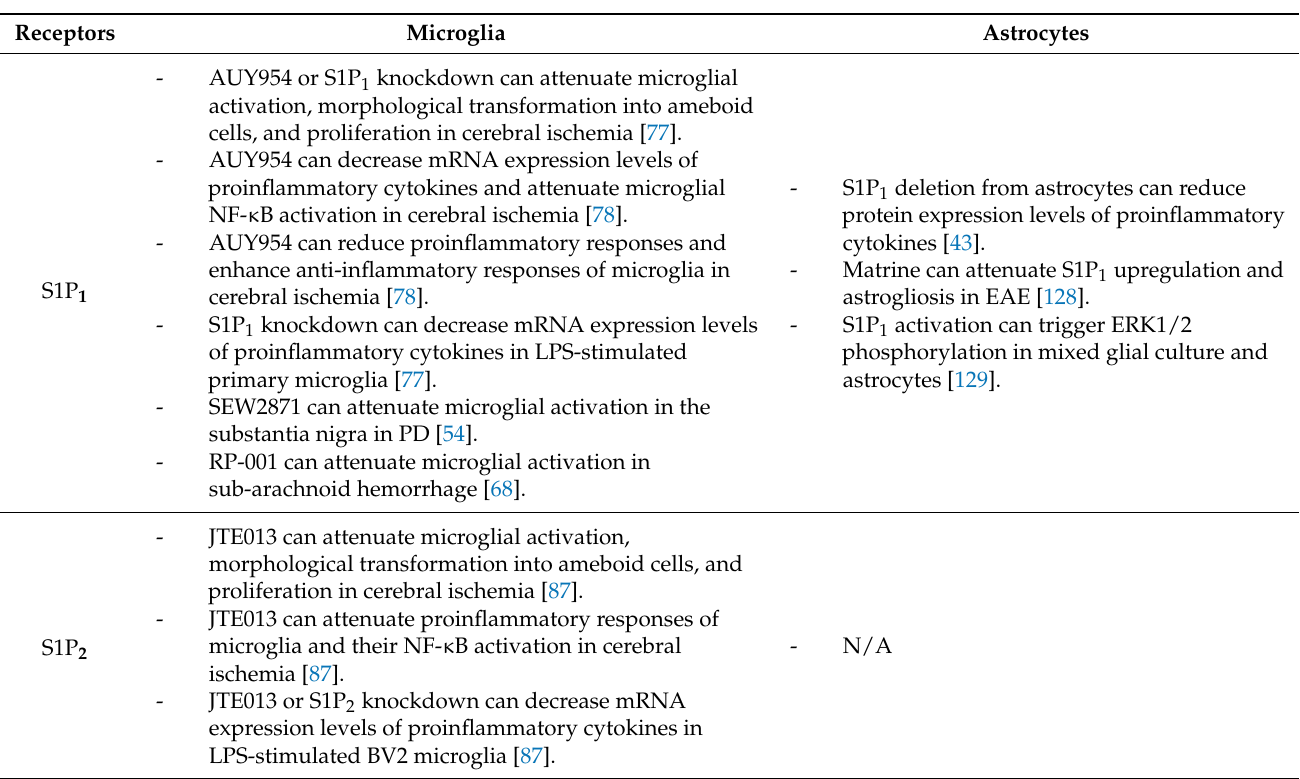
Table 1. S1P receptors in activation of neuroglia and their neuroinflammatory responses. N/A: not available. Receptors Microglia